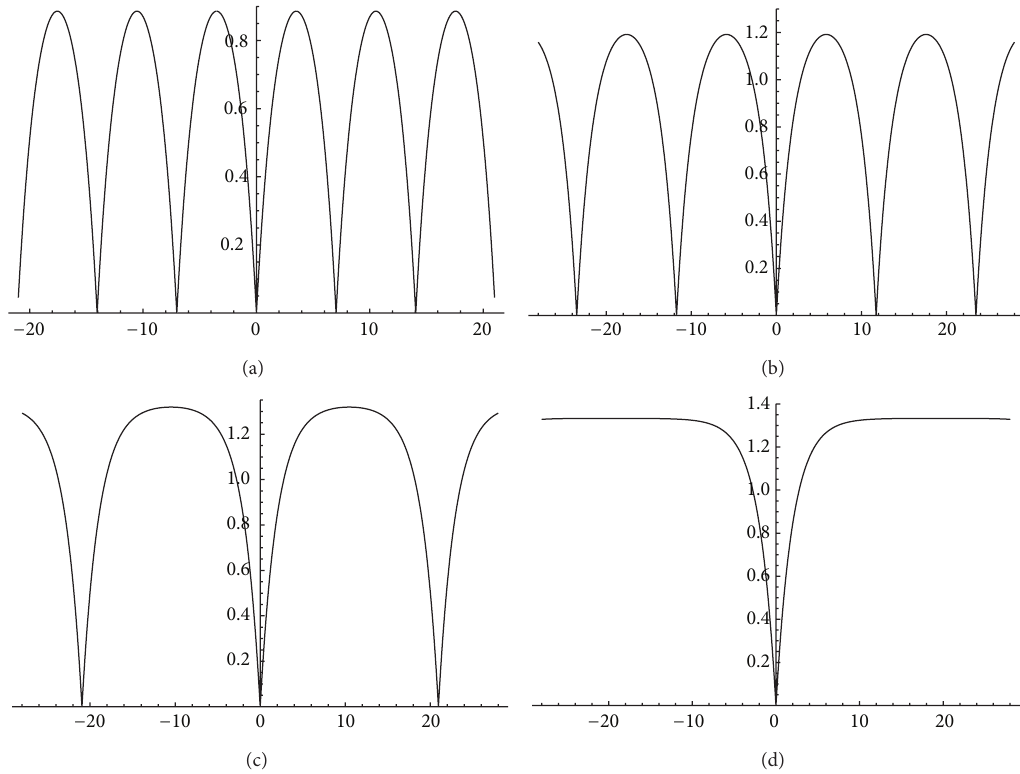
Figure 1: The varying process for the periodic peakon wave 𝑢 2 (𝜉) tends to the peakon wave 𝑢 1 (𝜉) when 𝑔 → 𝑔 1 + 0 , where 𝑎 = 1 , 𝑐 = −1 , and 𝑏 = 𝑘 = 1/2 , and (a) 𝑔 = 𝑔 1 + 10 −1 ; (b) 𝑔 = 𝑔 1 + 10 −2 ; (c) 𝑔 = 𝑔 1 + 10 −4 ; (d) 𝑔 = 𝑔 1 + 10 −8